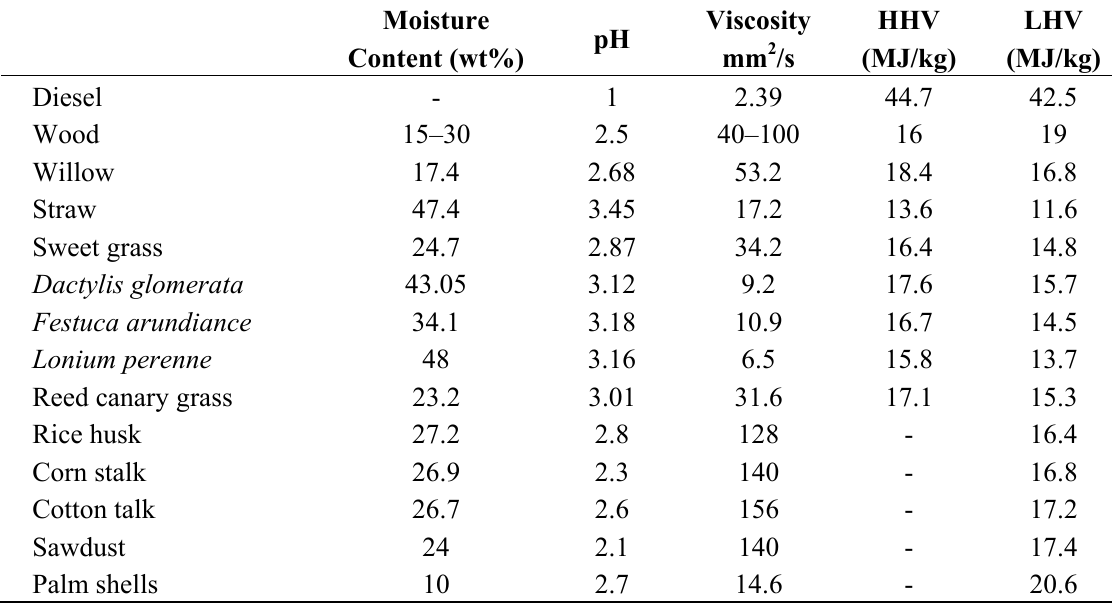
Table 8. Properties No.2 Diesel fuel and pyrolysis bio-oil from different feed stocks [31,54,65,82].